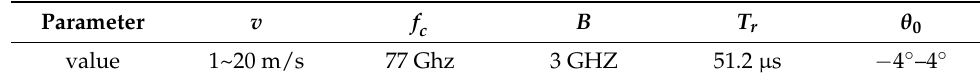
Figure 2. Time-frequency characteristics of transmitted/received signals. Table 1. Automotive SAR parameters.